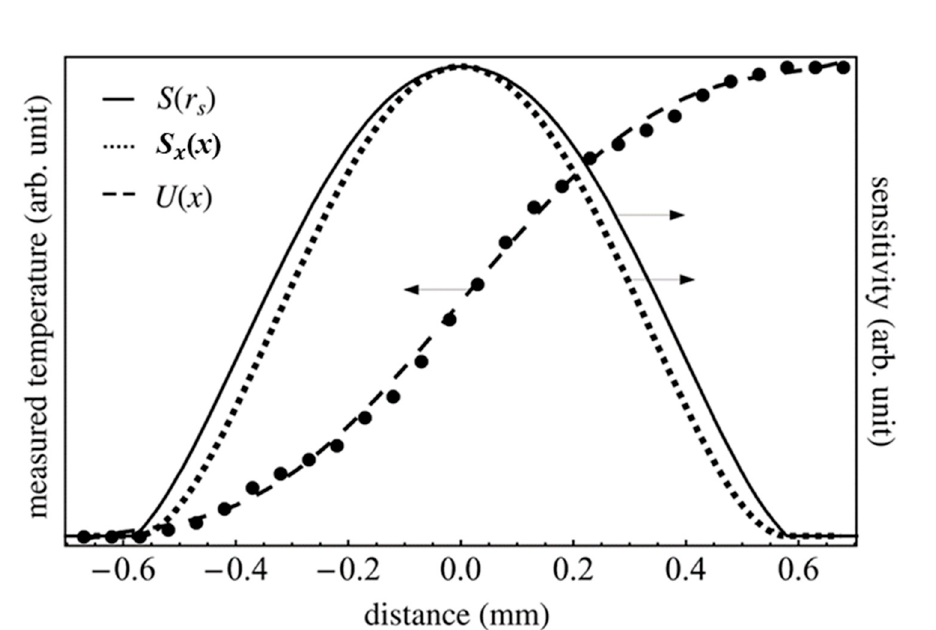
Figure 4. Detected temperature distribution of the plate heater and spatial resolution of the infrared detector. For the negative r s , the values of S ( − r s ) were plotted as S ( r s ) was axisymmetric for r s = 0.